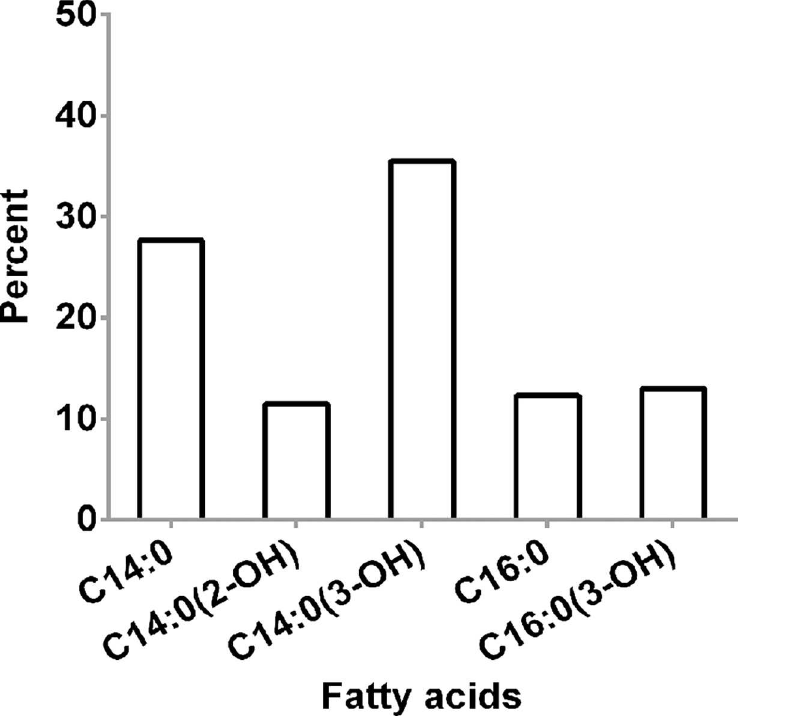
Fig 3. Fatty acid composition of B . pseudomallei K96243 lipid